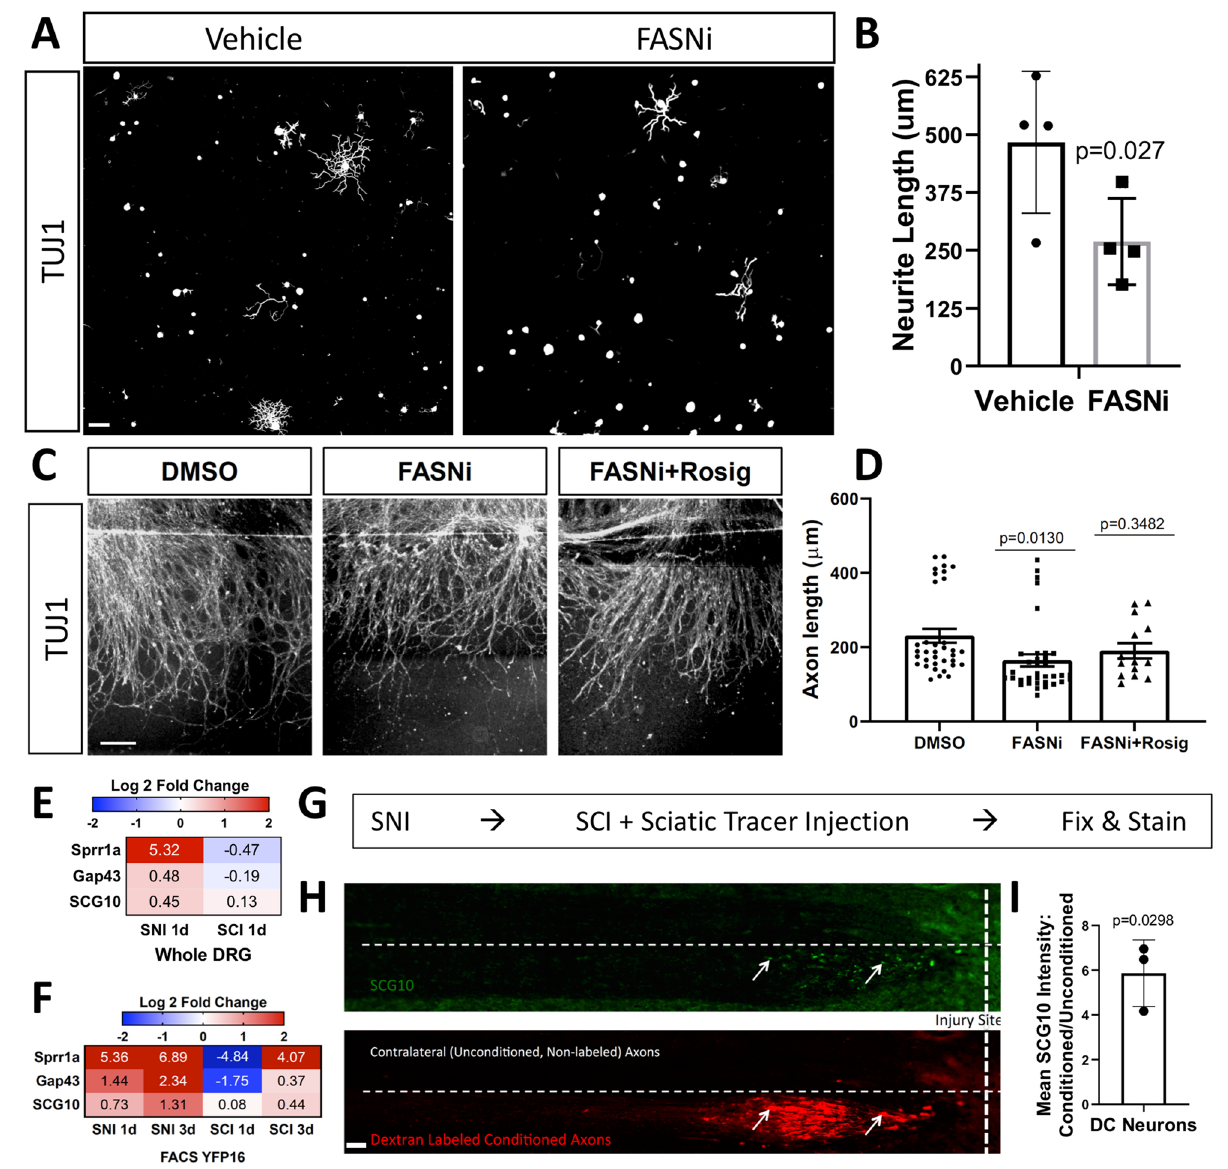
Figure 4. FASN inhibition decreases sensory neuron growth in vitro. ( A ) Representative images of TUJ1- labeled sensory neurons cultured from L4 dorsal root ganglion (DRG), that were treated with vehicle or 1 um of platensimycin 1 h after plating, and then allowed to grow for 24 h in culture. ( B ) Quantification of ( A ) indicating the average neurite length for each neuron for each condition. Automated neurite tracing and length quantifications were performed using Nikon NIS-Elements (Version 4.60). The specific analysis code for digital reconstruction of neurites is available upon request (requires NIS-Elements and General Analysis https ://www. micro scope .healt hcare .nikon .com/produ cts/softw are/nis-eleme nts) (n = 4 mice/condition; Unpaired t-test). ( C ) Embryonic DRG spot cultures axotomized at DIV7 after a 24 h pre-treatment with DMSO as a control, platensimycin or platensimycin combined with rosiglitazone. Cultures were fixed after 24 h and stained with SCG10. Scale Bar: 50 µm. ( D ) Quantification of ( C ) indicating the distance of regenerating axons measured from the injury site. ( E,F ) Heatmap of genes for known axonally-trafficked protein genes 1 and 3 days after SNI and SCI in whole DRG or fluorescence-activated cell sorted (FACS) ascending DRG sensory neurons from Thy1YFP16 mice. (SNI (n = 3 mice) and SCI (n = 4 mice) for C; n = 3 mice per group, except n = 4 mice for naïve and SCI 1d for D). ( G ) Schematic indicating the experimental design for the in vivo conditioning experiment. ( H ) Representative images of horizontal sections of the dorsal column labeled with SCG10 and dextran-labeled conditioned axons that was injected into the ipsilateral sciatic nerve. ( I ) Quantification of ( H ) indicating the ratio of mean SCG10 staining intensity between conditioned and unconditioned axons of ascending DRG sensory neurons (n = 3 mice; One-sample t-test and Wilcoxon signed rank